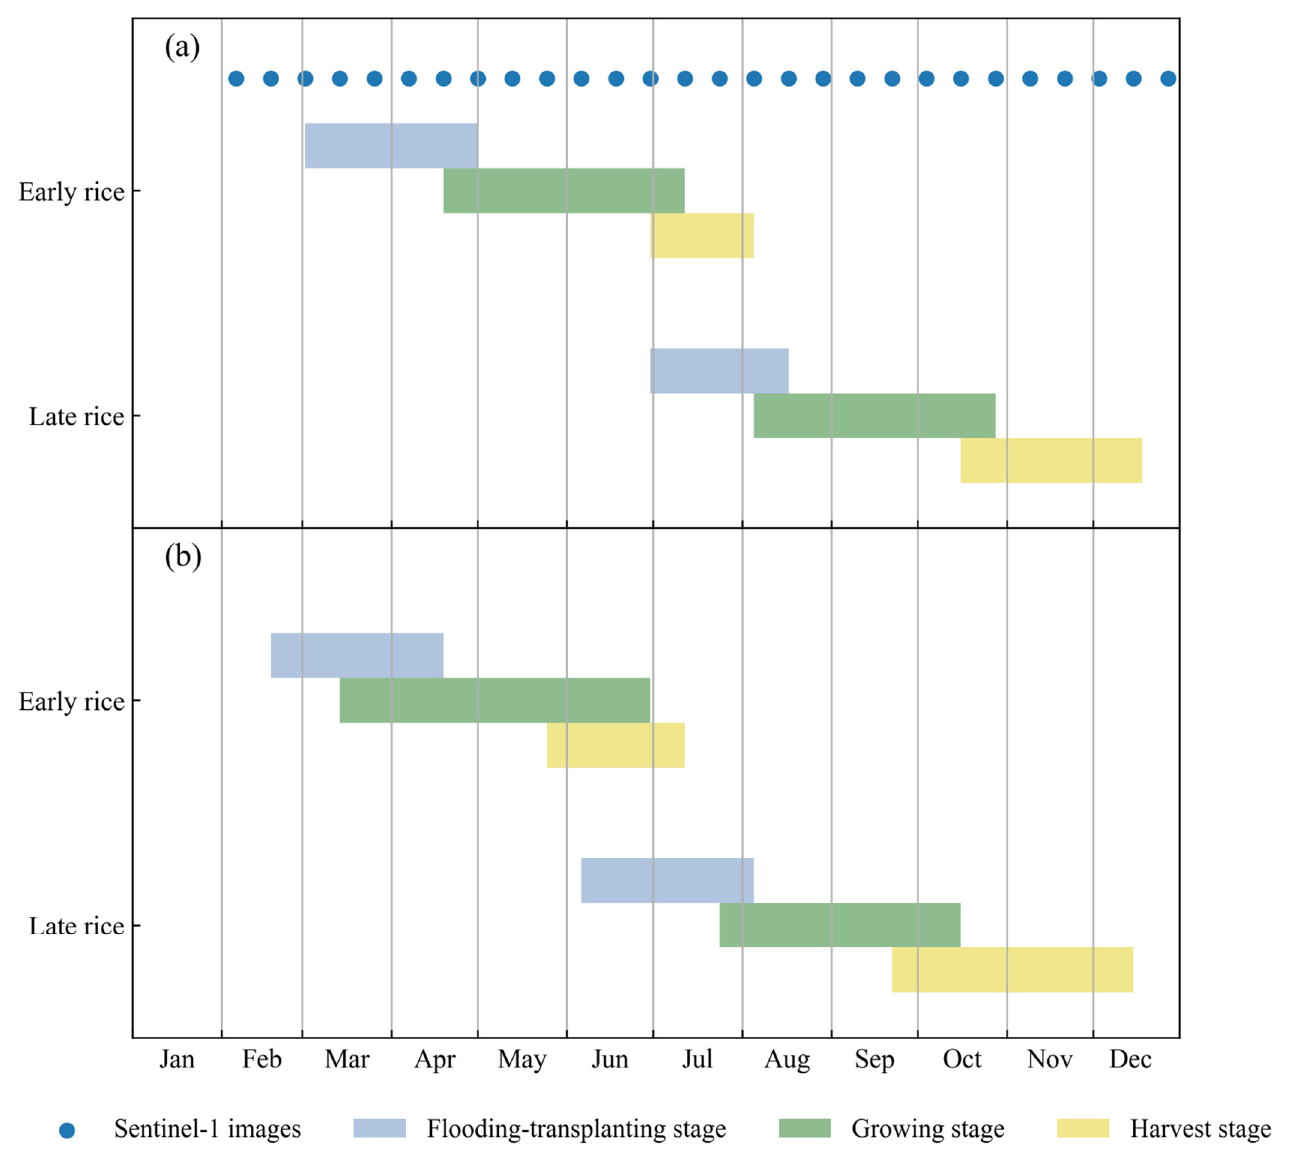
Figure 3. Rice cropping calendar and Sentinel-1 image acquisition dates at Guangdong, Guangxi, Hunan, Jiangxi, Fujian provinces, Hubei, Anhui, Zhejiang provinces ( a ) and Hainan province ( b ).